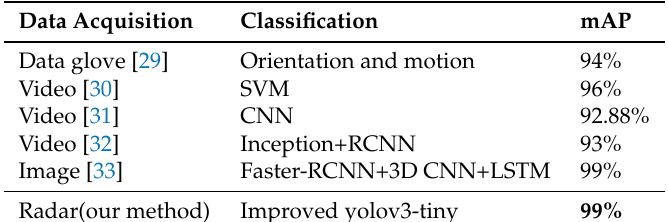
Table 4. Mean average precision (mAP) comparison with other methods having different data acquisitions and